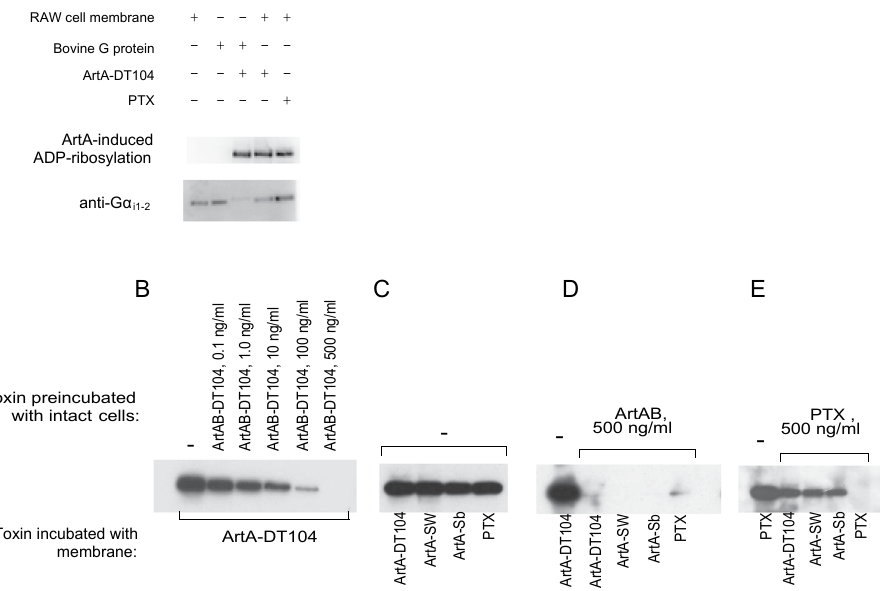
Figure 5. ArtABs catalyse ADP-ribosylation of G proteins in RAW 264.7 cells. ( A ) ADP-ribosylation of G proteins by ArtA-DT104. Upper panel, western blot showing biotin-ADP ribose labelling of Ptx-sensitive G proteins from the bovine brain and RAW 264.7 cell membranes (3.6 μ g) by ArtA-DT104 expressed in vitro (2 μ l) or Ptx (100 ng), in the presence of biotin-NAD. Samples were resolved by 12.5% SDS-PAGE, and ADP- ribosylated proteins were detected by western blotting using peroxidase-conjugated streptavidin as described in Materials and Methods. Lower panel, western blot of the RAW 264.7 cell membrane fraction probed with anti-G α i1 and -G α i2 IgG antibodies. Lane 1, membrane fraction of RAW 264.7 cells; lane 2, Bovine G proteins; lane 3, Ptx-sensitive G proteins from the bovine brain incubated with ArtA expressed in vitro ; lane 4, RAW 264.7 cell membranes incubated with in vitro -expressed ArtA-DT104; lane 5, RAW 264.7 cell membranes incubated with Ptx. ( B – E ) In vitro ADP-ribosylation of cell membrane proteins after preincubation of RAW 264.7 cells with ArtAB-DT104 or Ptx. RAW 264.7 cells were incubated with the toxins indicated in upper row (Toxin preincubated with intact cells) for 16 h at 37 °C, and then cell membranes were prepared. The membranes from the pretreated cells were then incubated with the toxins indicated in bottom row (Toxin incubated with membrane; in vitro -expressed ArtA or Ptx) in the presence of biotin-NAD. ADP-ribosylated proteins were detected by western blotting as described above. Results are shown for cells preincubated with different concentrations of ArtAB-DT104 ( B ); with no toxin pre-treatment ( C ); with 500 ng of ArtAB-DT104 ( D ); and with 500 ng of Ptx ( E ). In the bottom row, toxin with membrane indicates which toxin was added along with biotinylated NAD to the membrane fractions during the in vitro membrane